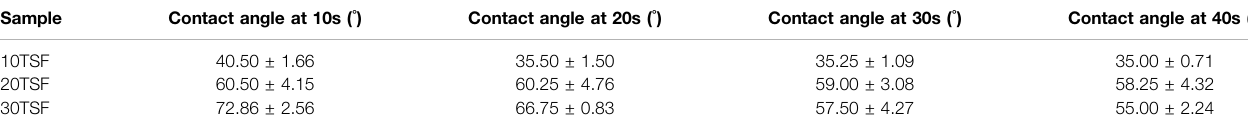
TABLE 1 | Dynamic contact angle of TSF nano fi ber mats after 10-, 20-, and 30-min physical shearing at different times. Sample Contact angle at 10s ( ° ) Contact angle at 20s ( ° ) Contact angle at 30s ( ° ) Contact angle at 40s ( °